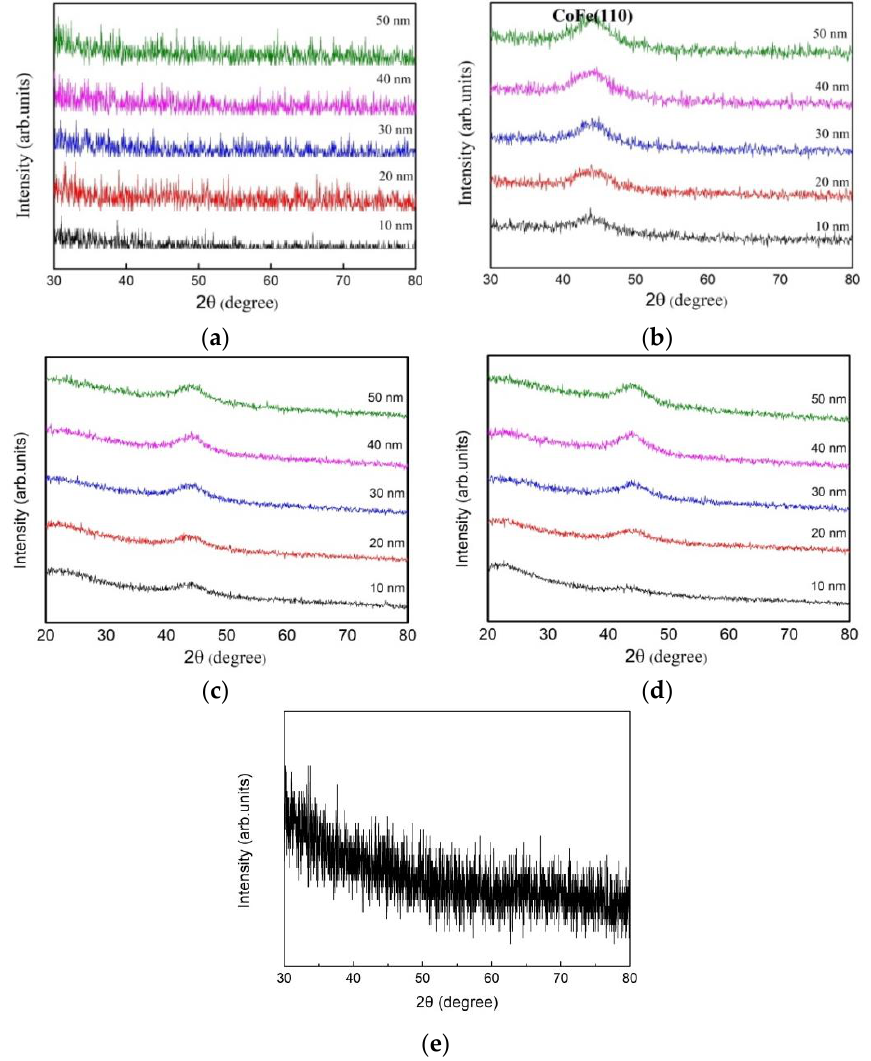
Figure 1. GIXRD patterns of Co 32 Fe 30 W 38 thin films. ( a ) RT, ( b ) annealed at 300 °C, ( c ) annealed at 350 °C, ( d ) annealed at 400 °C. ( e ) The GIXRD pattern of the glass substrate.